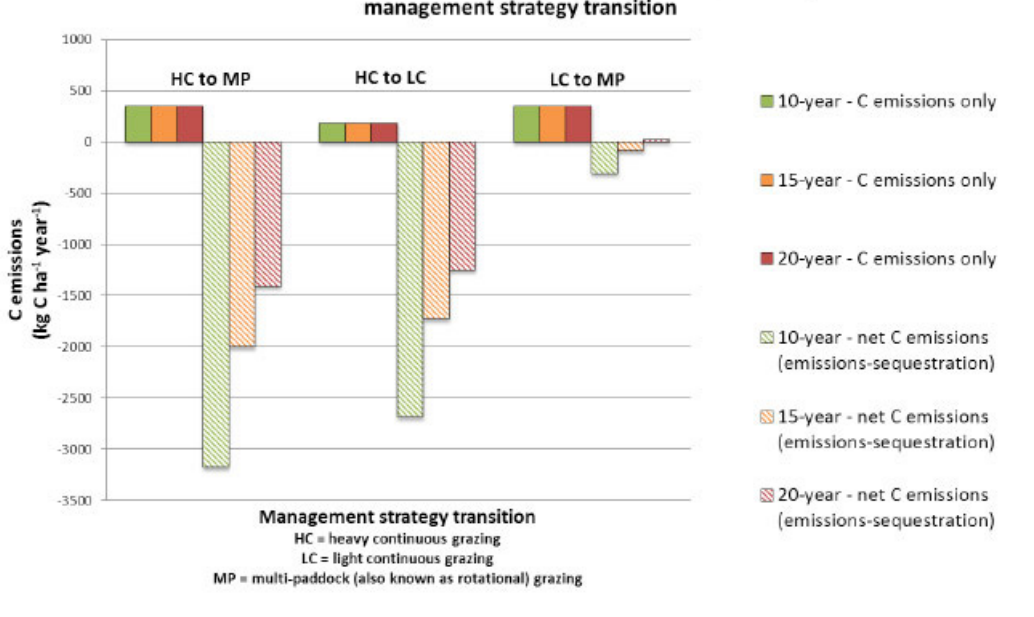
Figure 10: Carbon emissions after a change in grazing management strategy - with and without accounting for